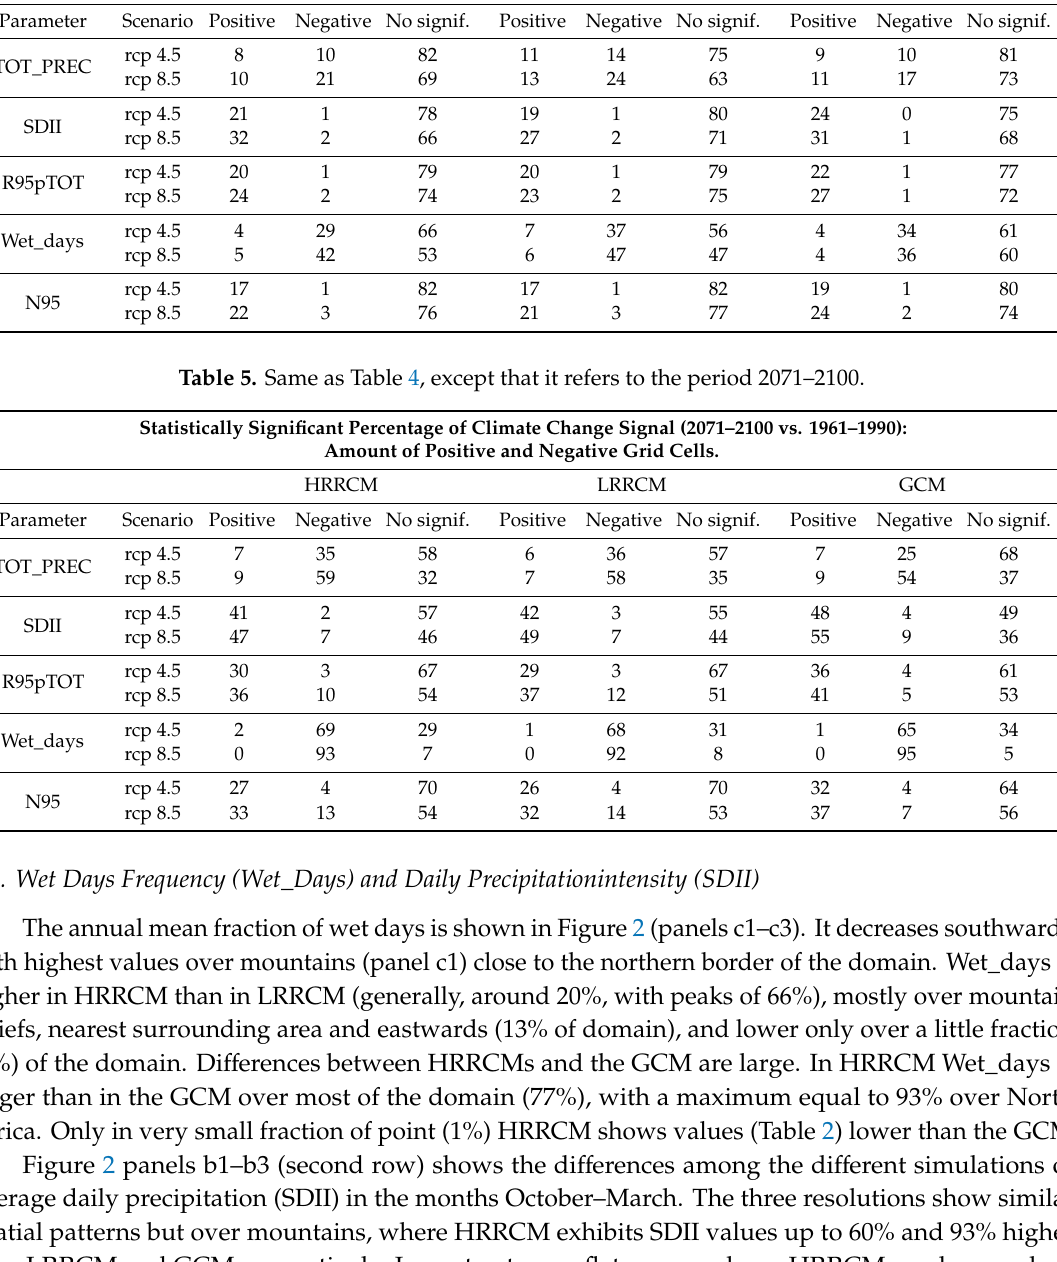
Table 4. Fraction (percent, %) of points with positive, negative and no statistically significant climate change signal for the high-resolution regional simulation (HRRCM), the low-resolution simulation (LRRCM) and the global simulation (GCM). Each line refers to a di ff erent indicator (see Section 2.2). Values refer to the 2021–2050 period with respect to the reference period 1961–1990. The column positive / negative denote points where the di ff erence between the near-term (2021–2050) and the reference (1961–1990) time periods in the RCP4.5and RCP8.5 are statistically significant. Positive values denote high indicators in the future (2021–2050) period.